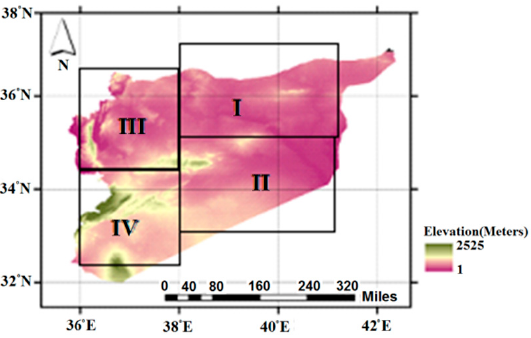
Figure 2. The locations of the four regions (I, II, III, IV) for precipitation statistics in Syria.